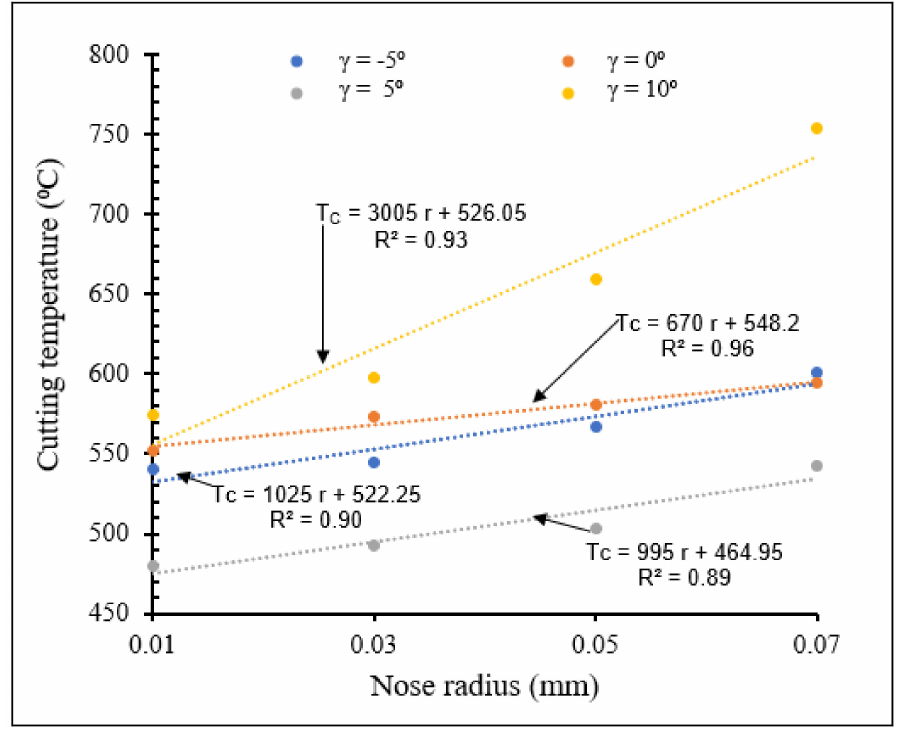
Figure 20. Variation of maximum temperature with small tool nose radius for different rake angles at V = 104 m/min, f = 0.1